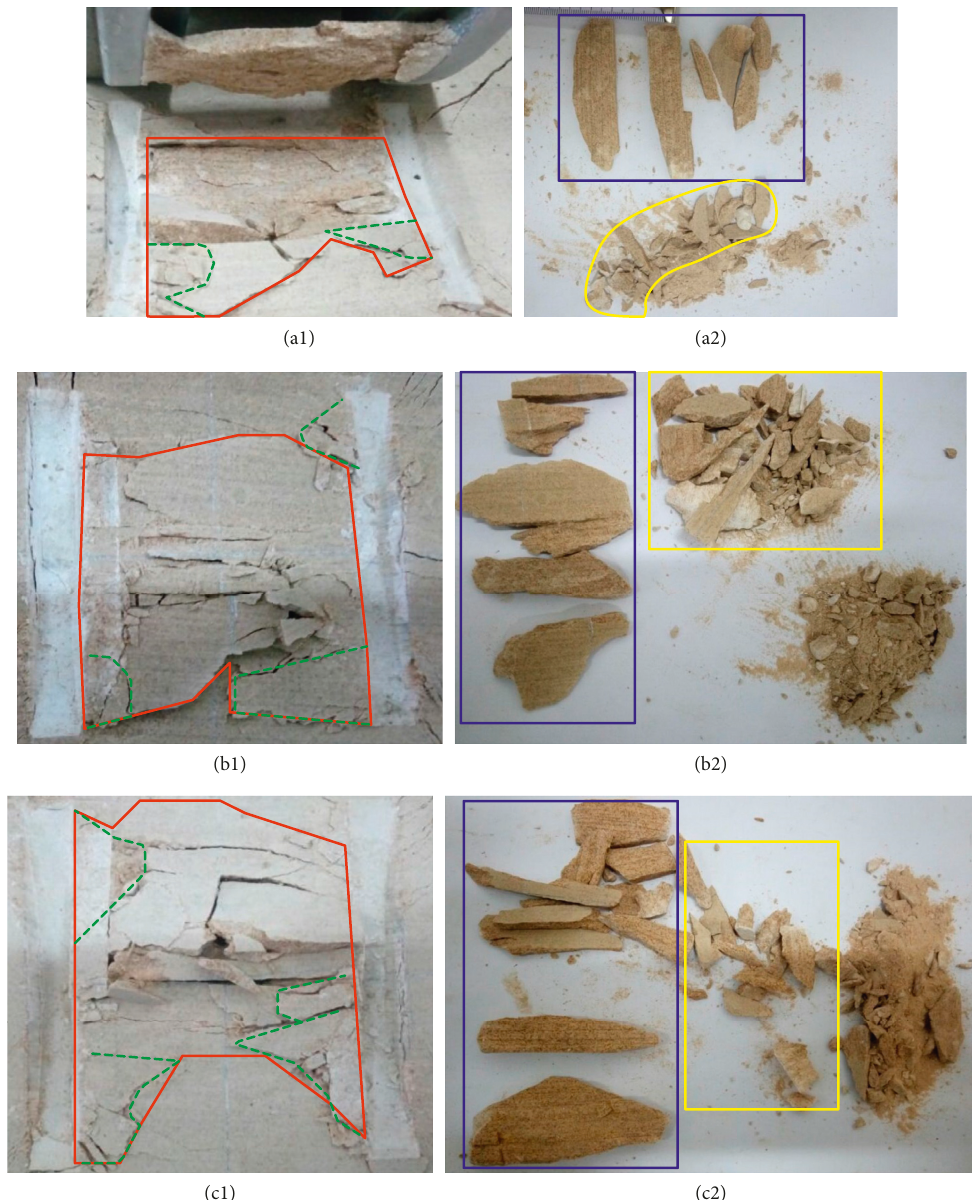
Figure 2: Rock breakages for the spacing of 80mm when the indentation depths were (a1, a2) 7mm, (b1, b2) 7.7mm, and (c1, c2)